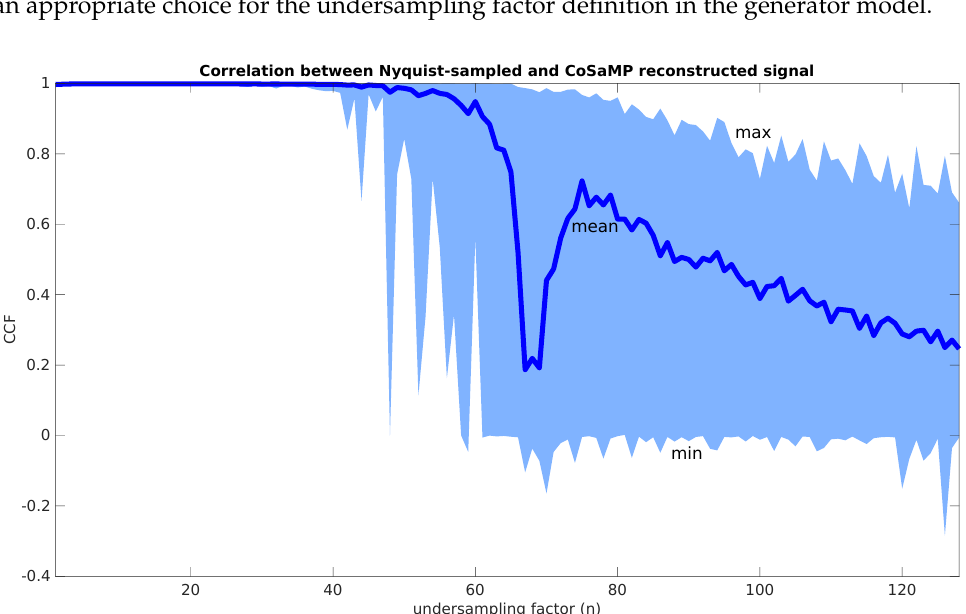
Figure 4. Monte Carlo simulation of the cross-correlation between the Nyquist − sampled test signal and its reconstruction for an undersampling factor n ranging from 1 to 128. The bounds for the confidence interval in the figure are the minimum and maximum results from the Monte Carlo simulation, whereas the thick blue line is the mean